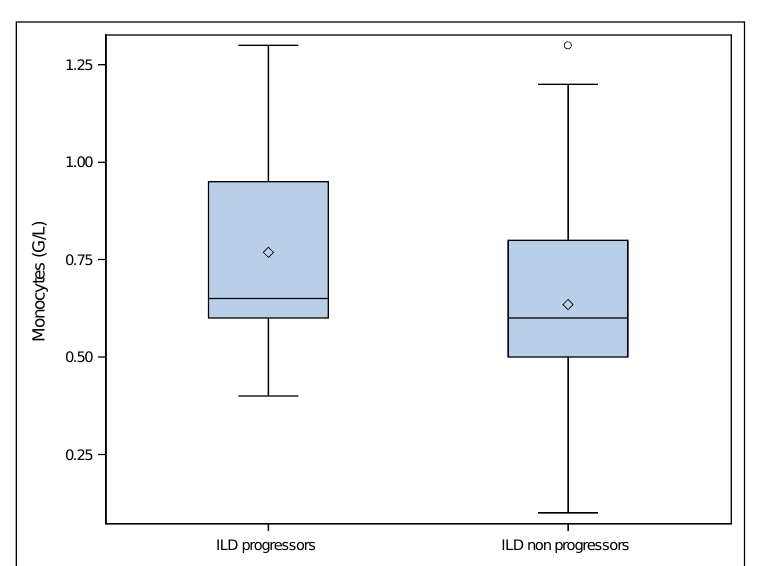
Figure 1. Comparisons of monocytes at baseline in ILD progressors and ILD non progressors. ° p value = 0.028. ILD progressors: patients with ILD at baseline who were progressors during follow up (19/146). ILD non progressors: patients with ILD at baseline who were non progressors during follow up (121/146). 6 patients had missing FVC data. The diamond corresponds to the values presented as median (IQR).